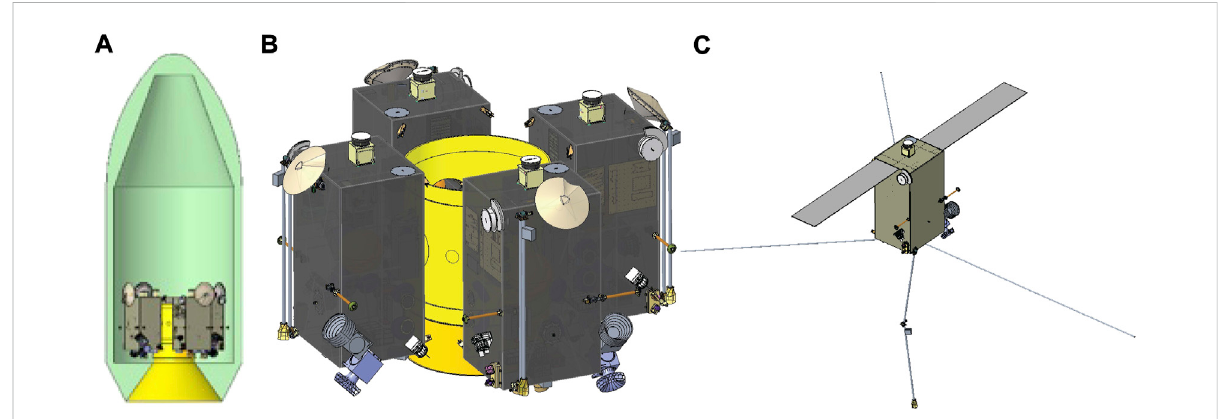
FIGURE 11 Four “ strawman ” InterMeso spacecraft in a stowed con fi guration mounted on an ESPA-Grande equivalent viewed inside a 5-m faring (A) and viewed without the faring (B) . (C) (A) “ strawman ” InterMeso spacecraft in the deployed con fi guration.